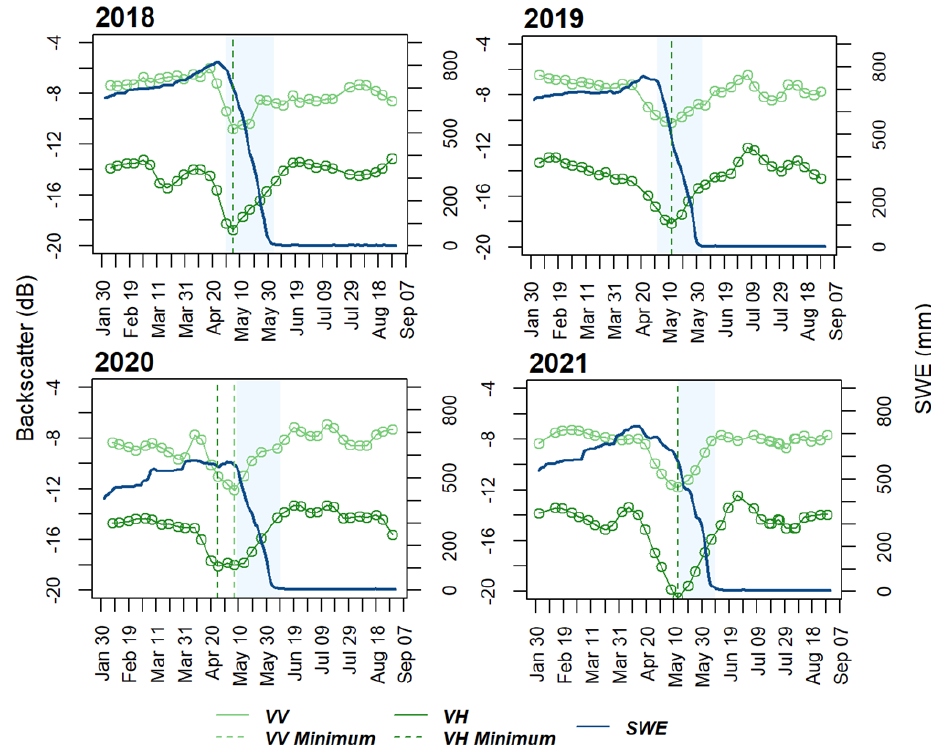
Figure 4. Comparisons of SAR time series and continuous snow water equivalence records (SWE) at Green Mountain. SWE records are displayed in dark blue, with melt periods shaded in light blue. SAR time series for VV and VH polarized images are depicted in green, with time series minima denoted by dashed